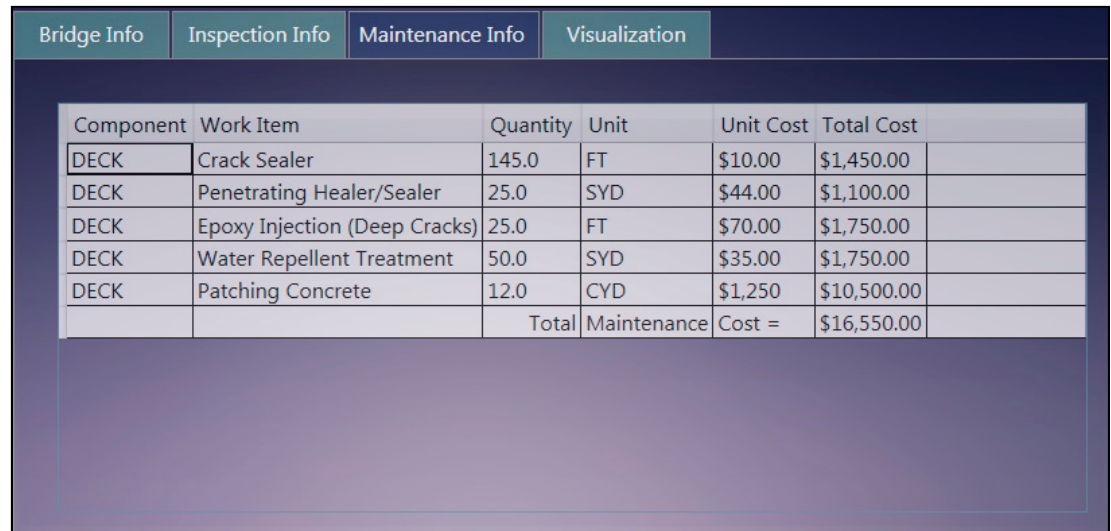
Figure 15. Maintenance cost analysis module in the software implementation of the decision support system.